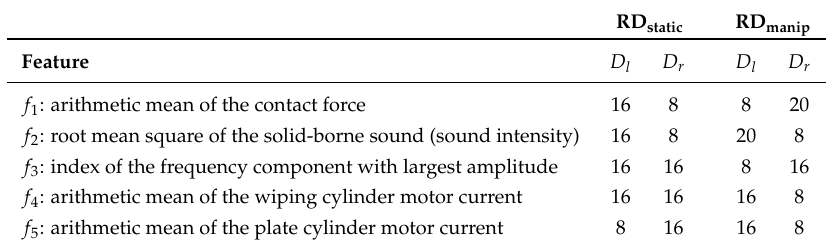
Table 3. Membership function parameters of the features with respect to the printing unit demonstrator condition monitoring data sets.